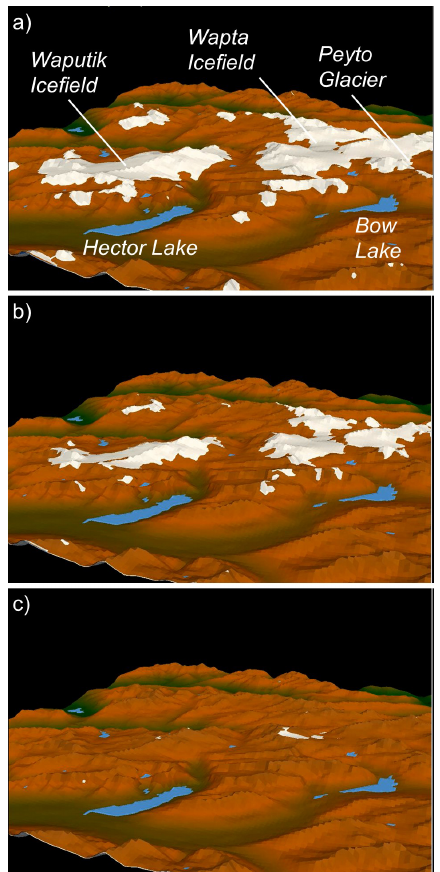
Figure 5. Simulated glacier projections in 3D perspective along the continental divide and in the headwaters of the Saskatchewan River for (a) 2005, (b) 2040, and (c) 2085 using the Canadian Earth Sys- tem Model under the RCP8.5 forcing scenario. Scale varies in the perspective, but the ground distance across the length of the Wa- putik Icefield in the 2005 scene is roughly 12km. Results are from Clarke et al.